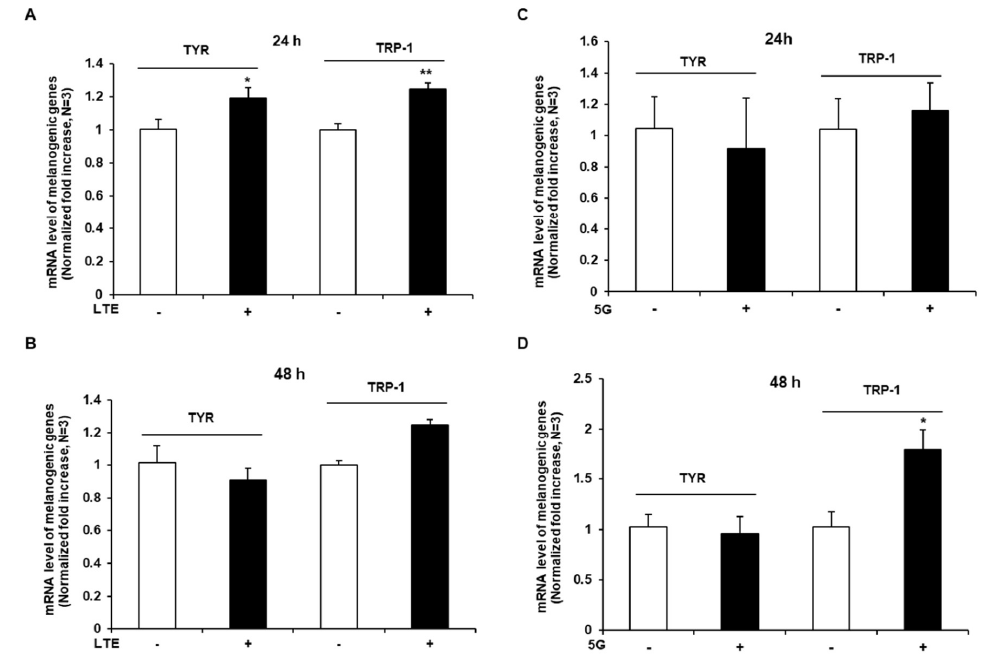
Figure 4. Effects of EMFs on mRNA level of melanogenic genes. The cells were exposed to either LTE or 5G for 4 h per day on indicated days. mRNA expression levels of tyrosinase and tyrosinase-related protein 1 (TRP-1) after ( A ) 24 h, and ( B ) 48 h exposure of LTE (1.762 GHz). mRNA expression levels of tyrosinase and TRP-1 after ( C ) 24 h, and ( D ) 48 h exposure of 5G (28 GHz). * p < 0.05, ** p < 0.01. Int. J. Mol. Sci. 2021 , 22 , x FOR PEER REVIEW